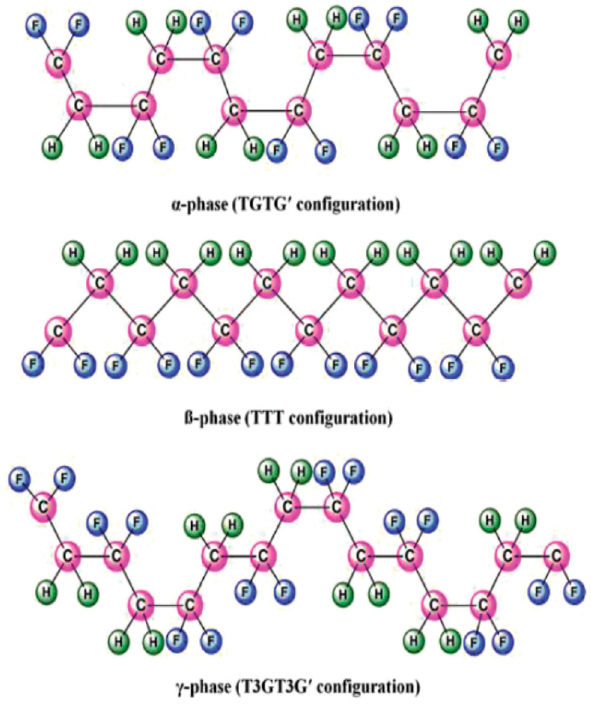
Figure 2. Primary polymorphic crystalline phases of PVDF. Reproduced with permission from [50], published by Wiley-VCH, 2019.